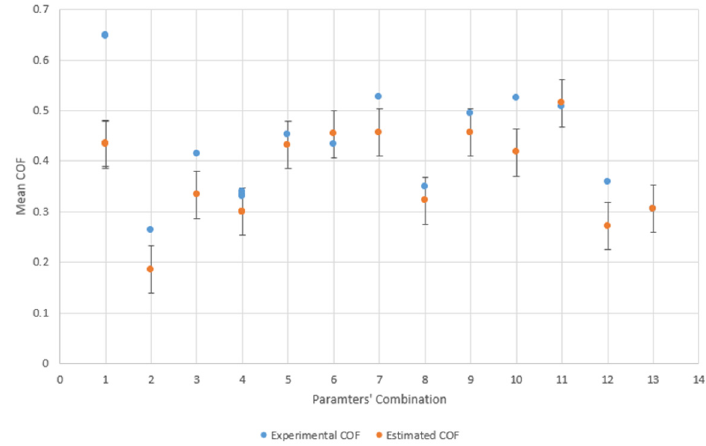
Figure 6. Estimated COF with confidence interval.